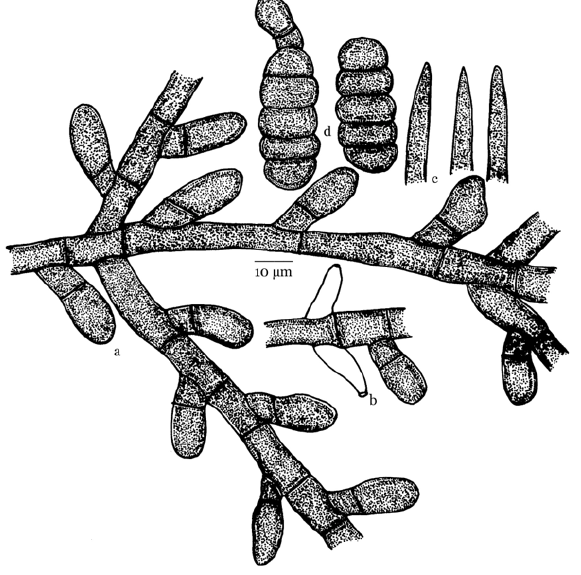
Figure 102. Meliola nothopegiae a - Appressorium; b - Phialide; c - Apical portion of mycelial setae; d - Ascospores